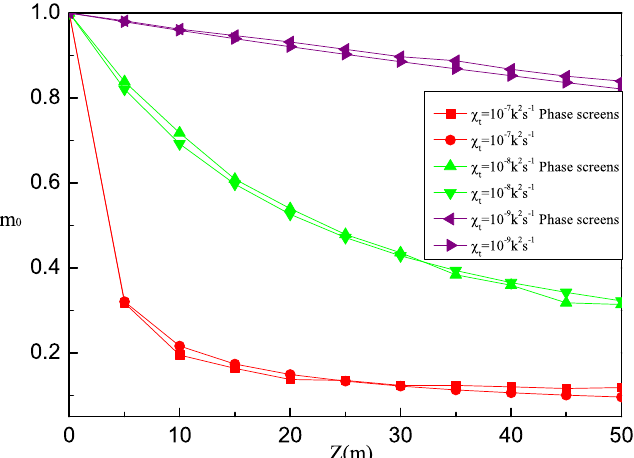
Figure 2. Detection probability P m mean-squared temperature χ t